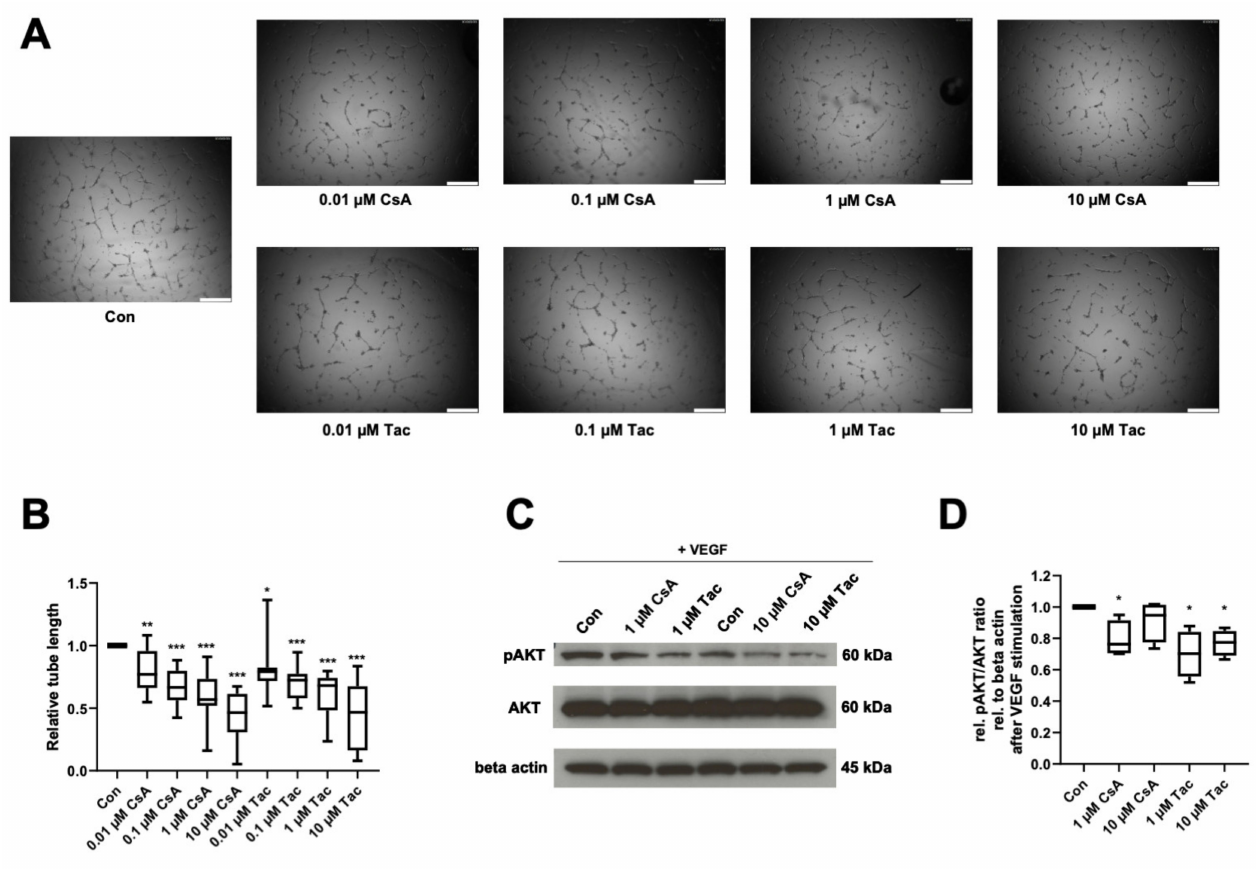
Figure 3. Cyclosporine A (CsA) and tacrolimus (Tac) impaired ECFC angiogenesis in presence of VEGF and reduced AKT phosphorylation. ( A ) Representative images from ECFCs treated with vehicle control only, 0.01 µ M CsA, 0.1 µ M CsA, 1 µ M CsA, 10 µ M CsA, 0.01 µ M Tac, 0.1 µ M Tac, 1 µ M Tac, 10 µ M Tac for 14 h, scale bar 500 µ m. ( B ) CsA and Tac treatment of ECFCs significantly decreased tube length after 14 h of incubation. Control group set as 1. n = 12. ( C ) Representative immunoblot of AKT phosphorylation in the presence of CsA or Tac (1 or 10 µ M) after 10 min of stimulation with VEGF. ( D ) CsA and Tac (1 or 10 µ M) prevented the VEGF-induced AKT phosphorylation in ECFCs. Control group set as 1. n =